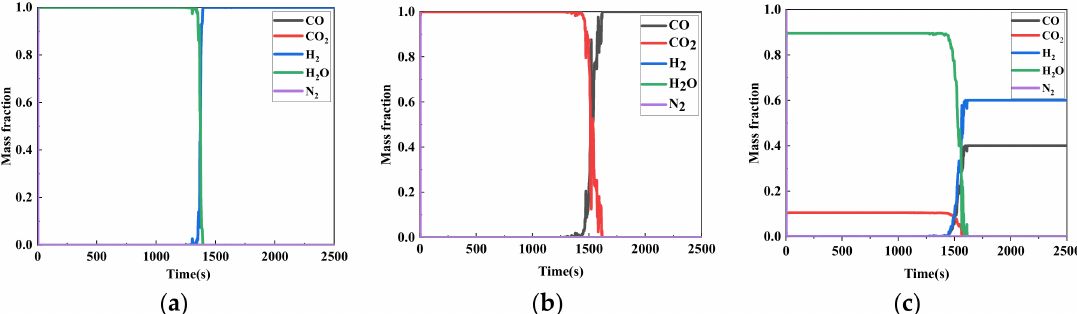
Figure 9. Changes in gas composition over time. ( a ) Experiments 7. ( b ) Experiments 8. ( c ) Experi- ments 9.